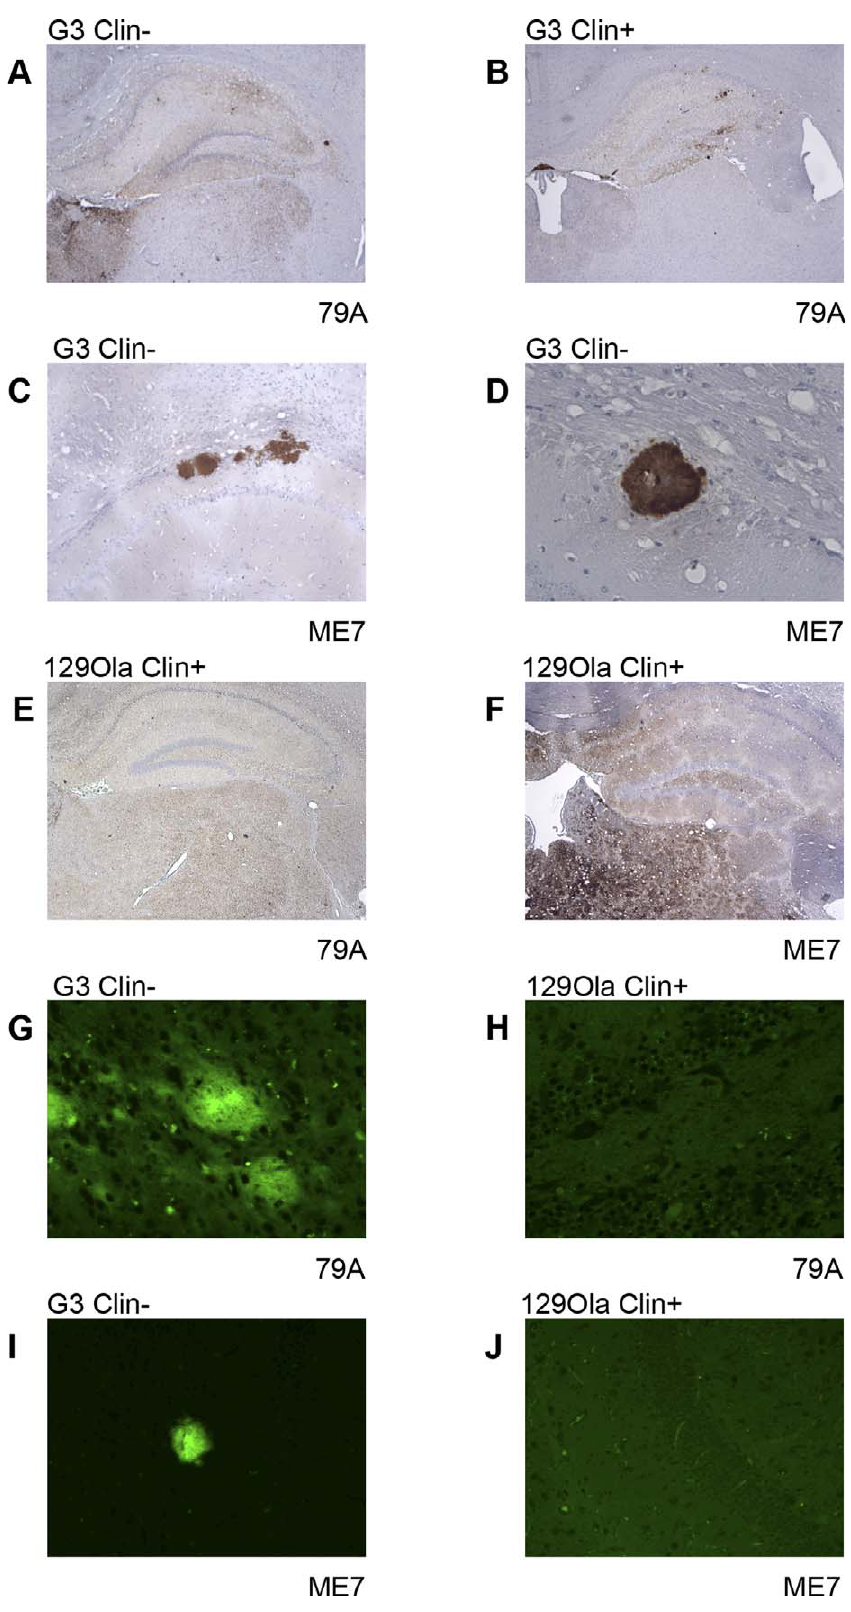
Figure 2. Immunohistochemical Analysis of Brain from G3 Mice Inoculated with TSE Strains 79A or ME7 Sections from the cerebrum and cerebellum were immunostained for PrP with monoclonal antibody 6H4 and analysed by light microscopy using a Nikon Eclipse E 800 microscope.